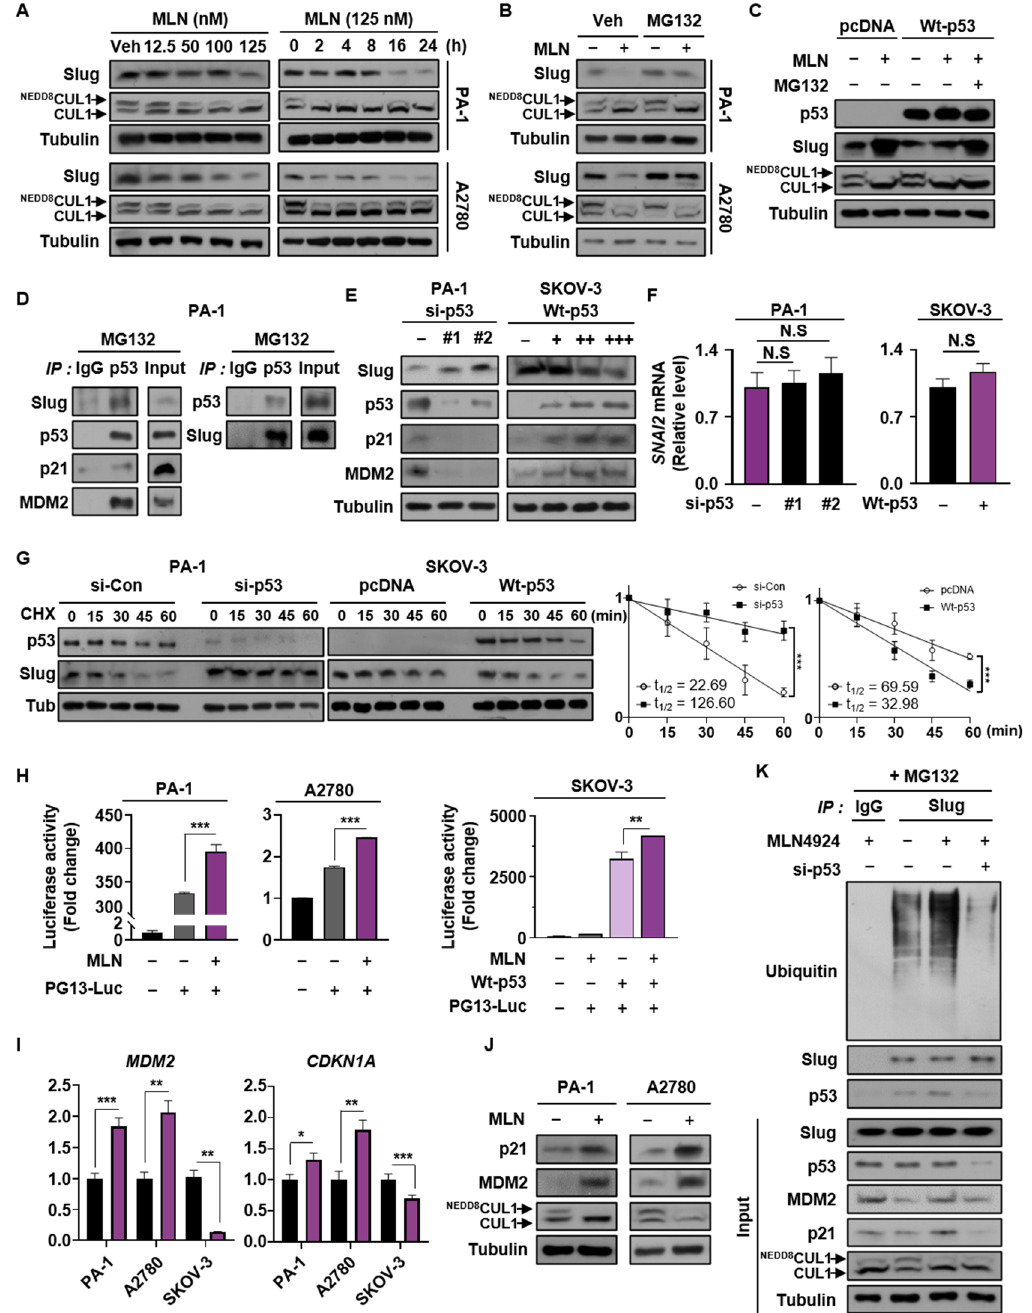
Figure 4. Neddylation blockade promotes proteasomal degradation of Slug in cancer cells expressing wild type p53. ( A ) PA-1 and A2780 cells were treated with MLN4924 at different doses and times. Slug expression was verified by Western blot analysis. ( B ) Cells treated with or without MLN4924 for 24 h were incubated with or without MG132 for 6 h, and the cell lysates were subjected to Western blot assays. ( C ) SKOV-3 cells transfected with pcDNA or Wt-p53 were incubated with or without MLN4924 and MG132, and the cell lysates were subjected to Western blot assays ( D ) PA-1 cells were treated with MG132 for 6 h, and the cell lysates were assessed by immunoprecipitation using anti-p53 or anti-Slug anti- bodies. Precipitated proteins were analyzed by Western blot assays. ( E ) PA-1 cells transfected with si-Control or si-p53 RNAs (#1, #2) and SKOV-3 cells transfected with different doses of wild type p53 DNA were subjected to immunoblotting. ( F ) PA-1 cells transfected with si-Control, si-p53#1, and si-p53#2, and SKOV-3 cells transfected with pcDNA and wild type p53 were subjected to RT-qPCR. ( G ) si-Control or si-p53 transfected PA-1 cells and pcDNA or wild type p53 transfected SKOV-3 cells were treated with cycloheximide for the indicated time, and then cell lysates were subjected to Western blotting. Band intensities (mean ± SD, n = 3) on blots were analyzed using ImageJ and plotted. ( H ) Cells were co-transfected with luciferase plasmid and the other plasmid shown and then subjected to luciferase reporter assays. The results were